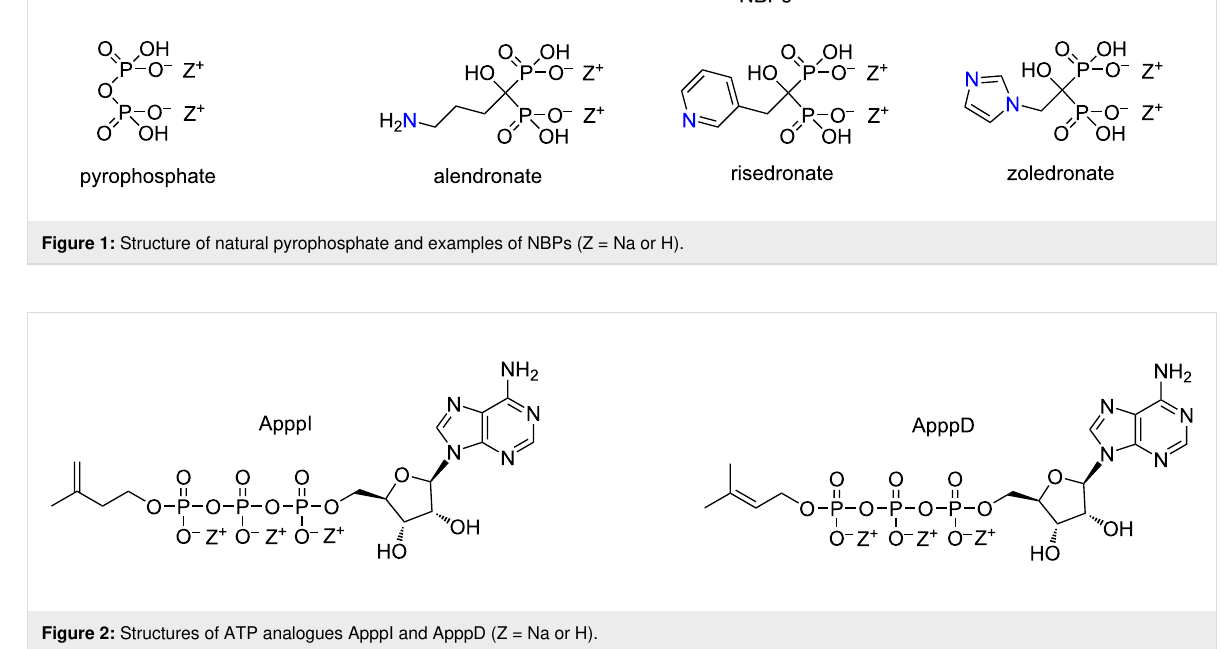
mechanism of action related to the antiresorptive and anti- cancer effects of NBPs has been proposed to be attributable to the metabolites formed in the mevalonate pathway induced by NBPs